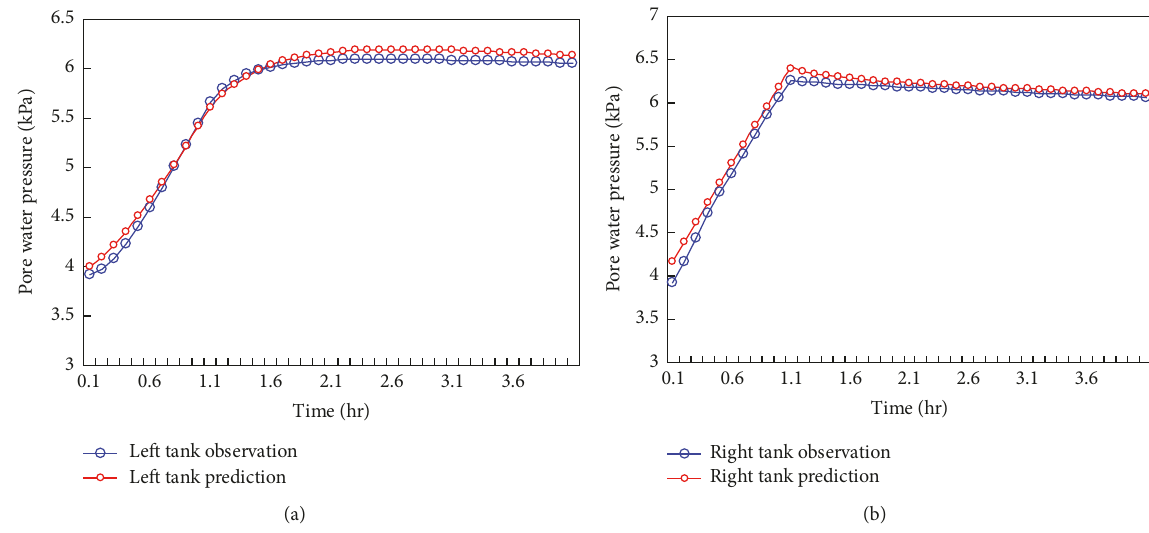
Figure 12: Prediction by modified tank model (fine material): (a) left tank and (b) right